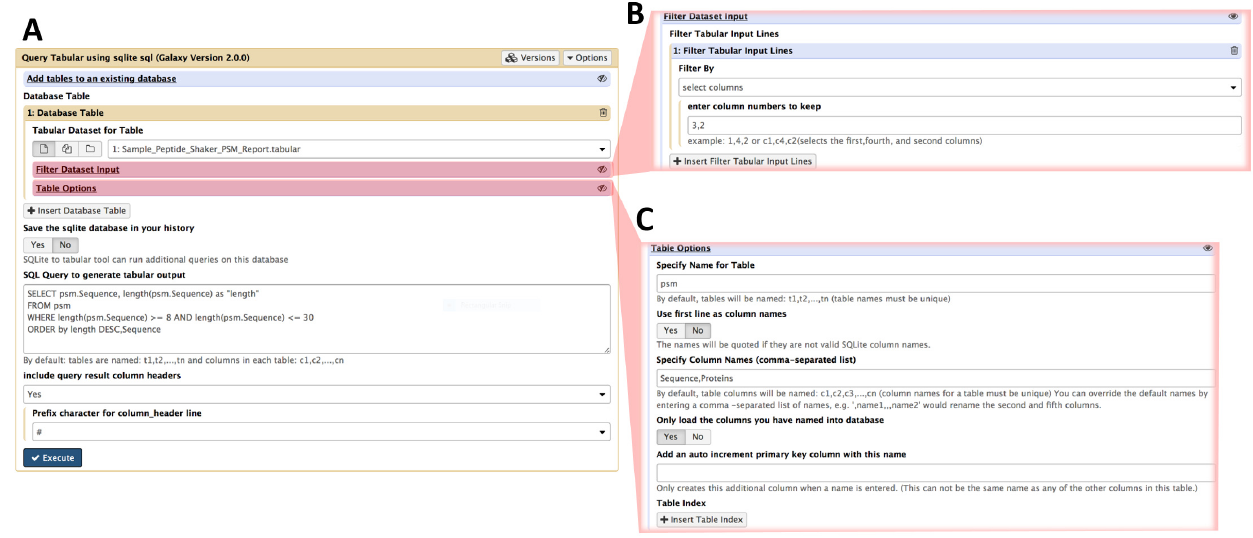
Figure 1. The Galaxy user interface for the Query Tabular tool. A ) The main interface for the Query Tabular tool. The user can select the tabular data which acts as input to be converted to a SQLite database table. The interface also provides a field to define the query for the SQLite database that will be carried out, along with options for displaying results from the query in the tabular output. B ) Expanded view of the the input filtering function. Any number of line filters can be sequentially applied as the tabular data is being read. Line filters can remove comment lines. They can add columns, either incrementing index, or text. Line filters can also “normalize” list columns within a tabular input line, producing one output line for each item in the list of the selected columns. The Query Tabular tool help section provides examples of using line filters for common situations. In this example, the input tabular data is passed through one line filter: “select columns”, and the user chose to keep data columns 3 and 2 in that order. C ) Expanded view of the table options function. In this example, the user named the